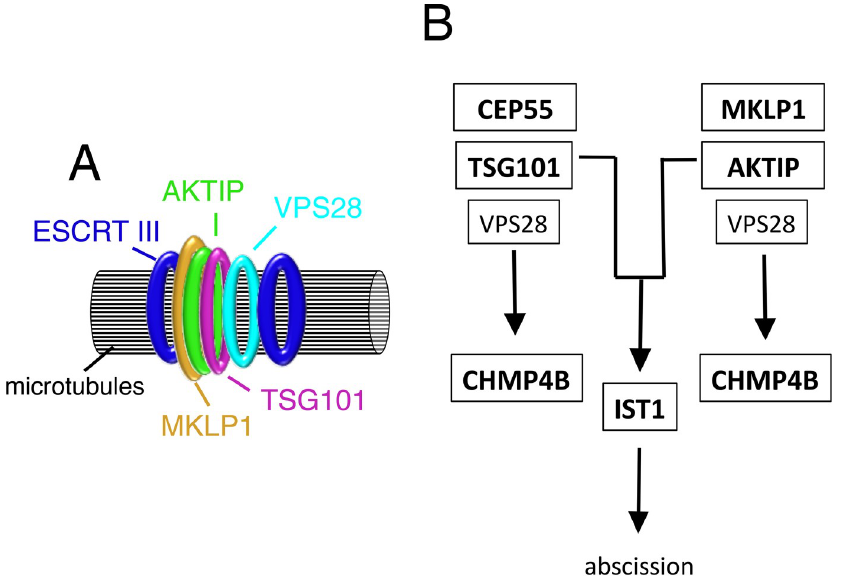
Fig 11. Schematic representation of AKTIP structural and functional association with the ESCRT machinery. (A) AKTIP localizes at the midbody in proximity with the annular structure formed by MKLP1 and with that formed by the ESCRT I subunit TSG101 and VPS28. AKTIP super-structure is flanked by the rings formed by the ESCRT III subunits CHMP4B, CHMP2A and IST1. (B) AKTIP is recruited to the midbody in a MKLP1 dependent, CEP55 independent way. AKTIP and TSG101 cooperate in the recruitment of CHMP4B to the midbody through independent routes, likely involving the ESCRT I subunit VPS28, that interacts with both TSG101 and AKTIP. AKTIP and TSG101 are needed for the recruitment of IST1 to the midbody, and act in a common pathway leading to abscission.